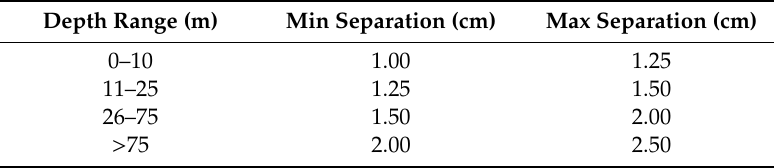
Figure 1. DTM is transformed to a point data set, which is generalized across scales according to the ladder approach. Table 2. Soundings ranges and corresponding separation distances [9].